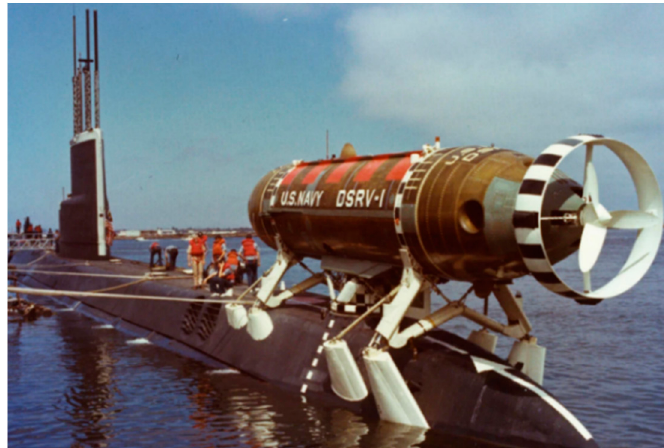
Figure 1. First-generation DSRV of the United States Navy [22].